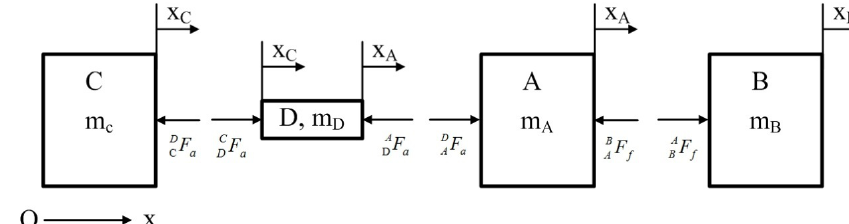
Figure 8. Free-body diagram of the PIFA components.